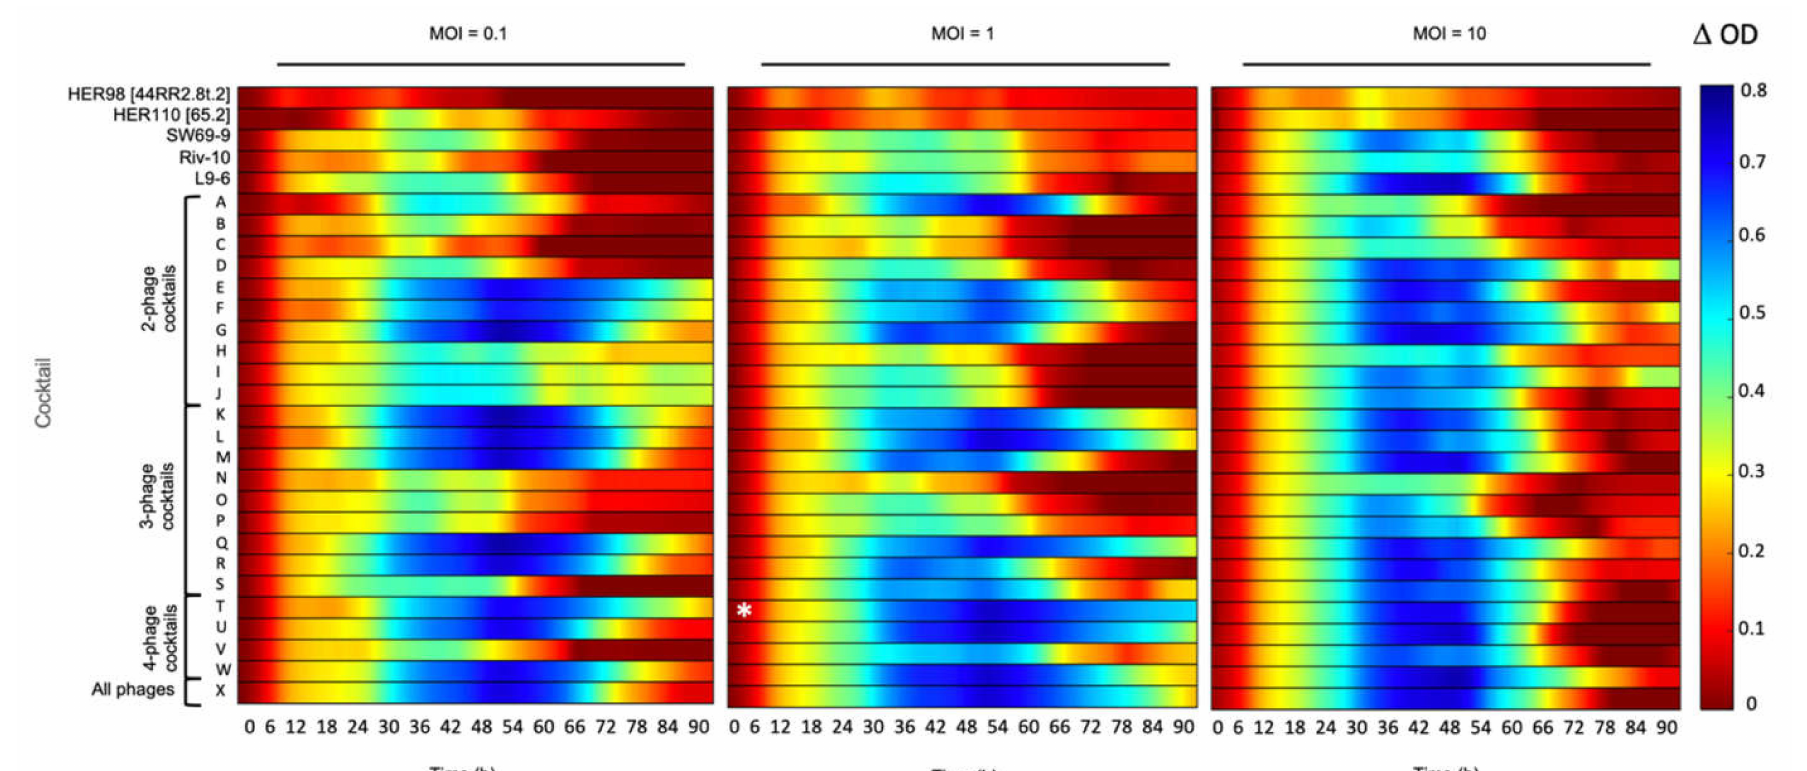
Figure 2. Growth inhibition of strain 01-B526 in presence of various phage combinations. The effect of individual phages and 24 phage combinations (A to X, see Table S1 for phage combination details) at three different MOIs (0.1, 1, and 10) on the growth of strain 01-B526 are shown from left to right. The colored lines representing the growth inhibition by phages have been determined as shown in Figure 1. When the bacterial growth is highly inhibited, the color of the line will tend to blue. No inhibition corresponds to red lines. According to the colored lines, Cocktail T, which included phages HER98 + HER110 + SW69-9 + Riv-10 (MOI = 1), is the best combination for bacterial growth inhibition (white